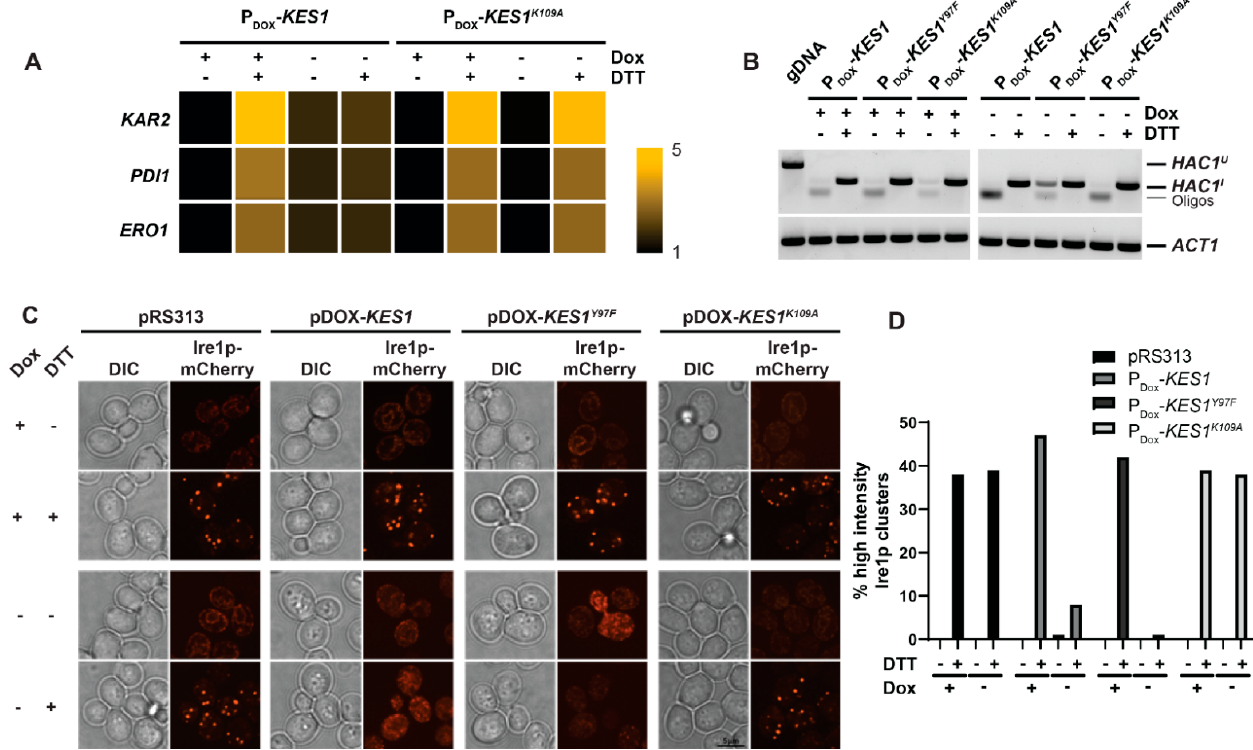
Figure 2. Kes1p hyperactivity attenuates the UPR and Ire1p clustering. ( A ) RT-PCR data of UPR- associated genes in wild-type cells containing vectors for doxycycline-repressible P DOX - KES1 , P DOX - KES1 Y97F and P DOX - KES1 K109A overexpression. Cells were treated with ± 5 mM DTT for 2 h prior to sample collection. ( B ) RT-PCR of HAC1 in wild-type cells containing vectors for doxycycline- repressible P DOX - KES1 , P DOX - KES1 Y97F and P DOX - KES1 K109A overexpression. Cells were treated with ± 5 mM DTT for 2 h prior to sample collection. gDNA was used as a negative control for HAC1 splicing and ACT1 was used as RT-PCR control. ( C ) Fluorescence microscopy images taken of Ire1-mCherry from wild-type cells transformed to determine role of KES1 overexpression of Ire1 clustering. Vectors used include pRS313 (empty HIS3 vector), P DOX - KES1 , P DOX - KES1 Y97F , and P DOX - KES1 K109A . Cells were cultured either in the presence or absence of 10 µ g/mL doxycycline. ( D ) Cell counts determining the proportions of cells containing high-intensity Ire1-mCherry clusters (taken from microscopy images described above). At least 150 cells were counted for each